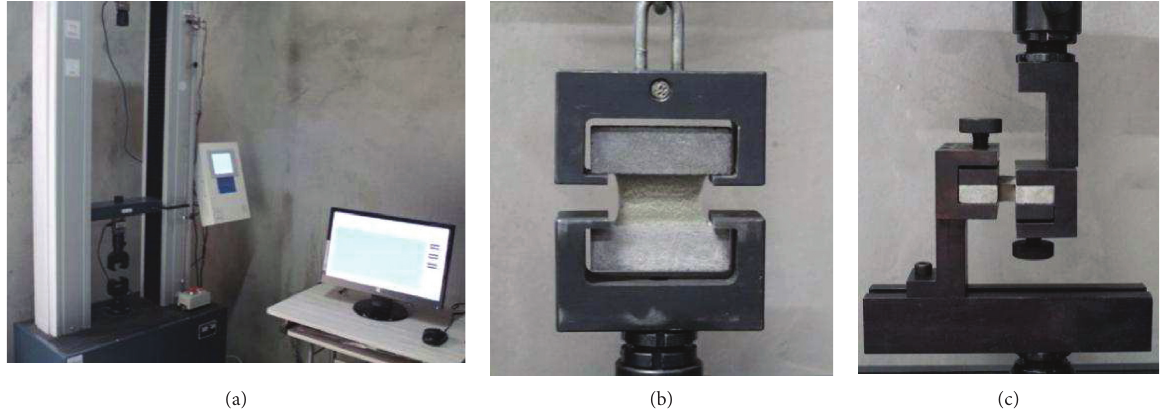
Figure 4: Tensile and shear testers: (a) electronic tensile tester; (b) grip for tensile test; (c) grip for shear test.